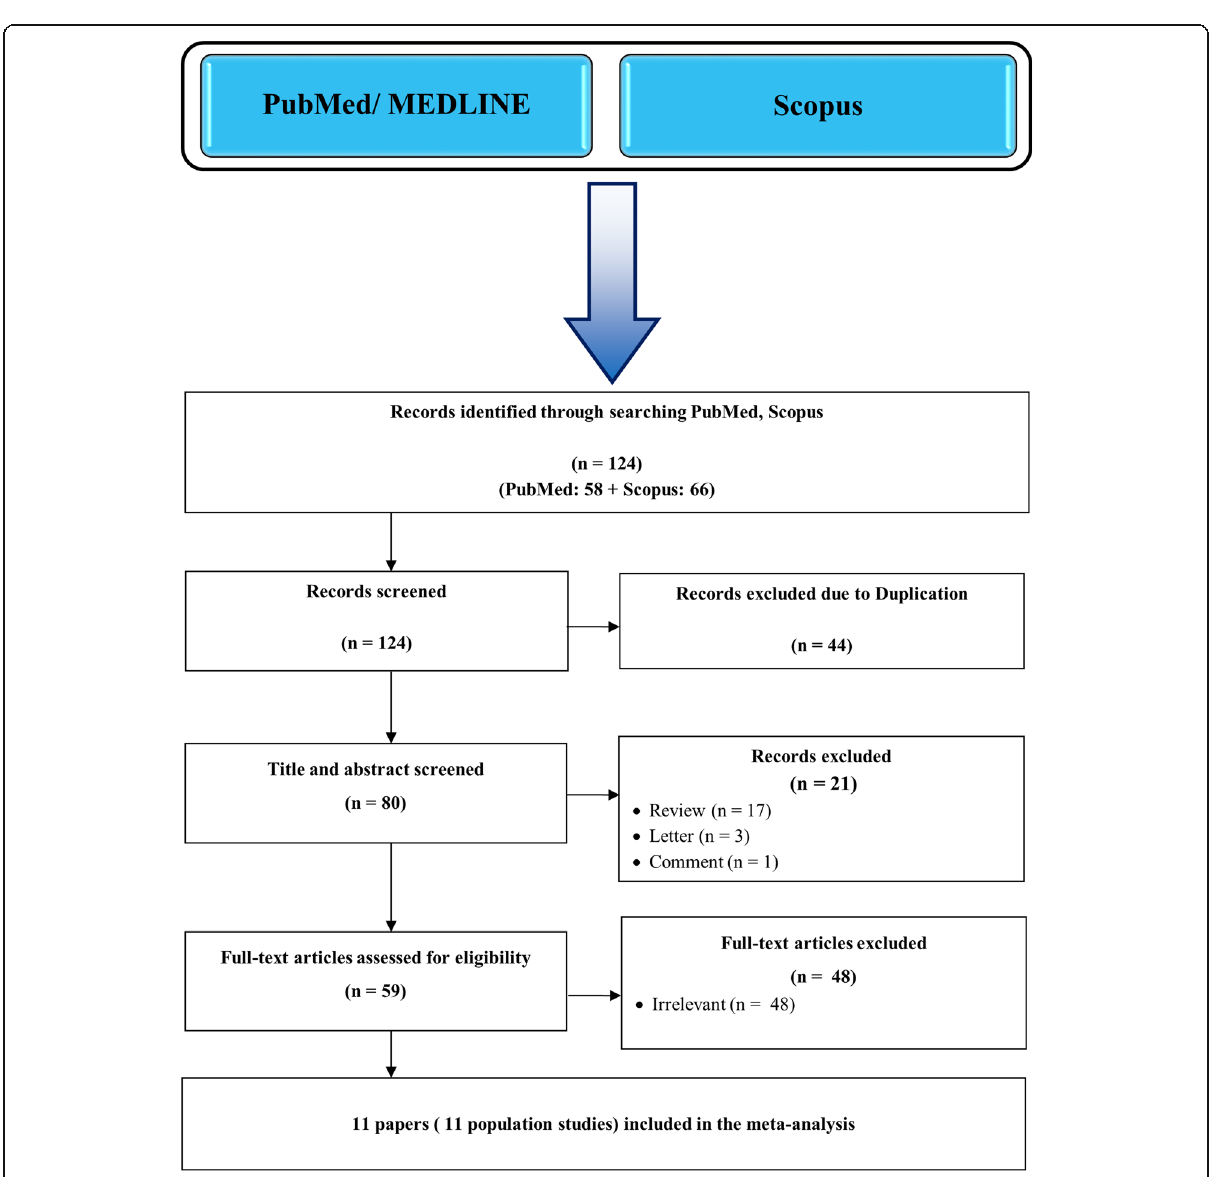
Fig. 1 Flow chart of specifications and procedure for the literature search and study